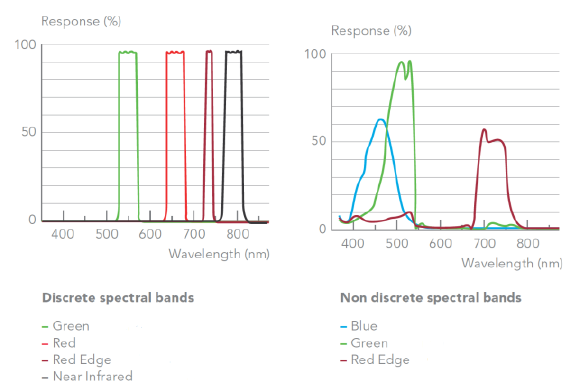
Figure 9. Wavelength and response of discrete and non-discrete spectral bands (Micasense,